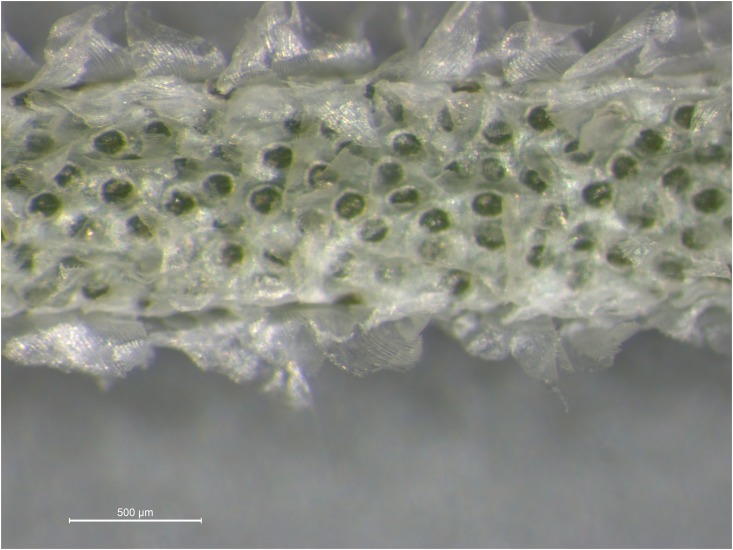
Close-up microscope photo of Spanish moss (Tillandsia usneoides L.).Peltate scales (trichomes) are displayed.